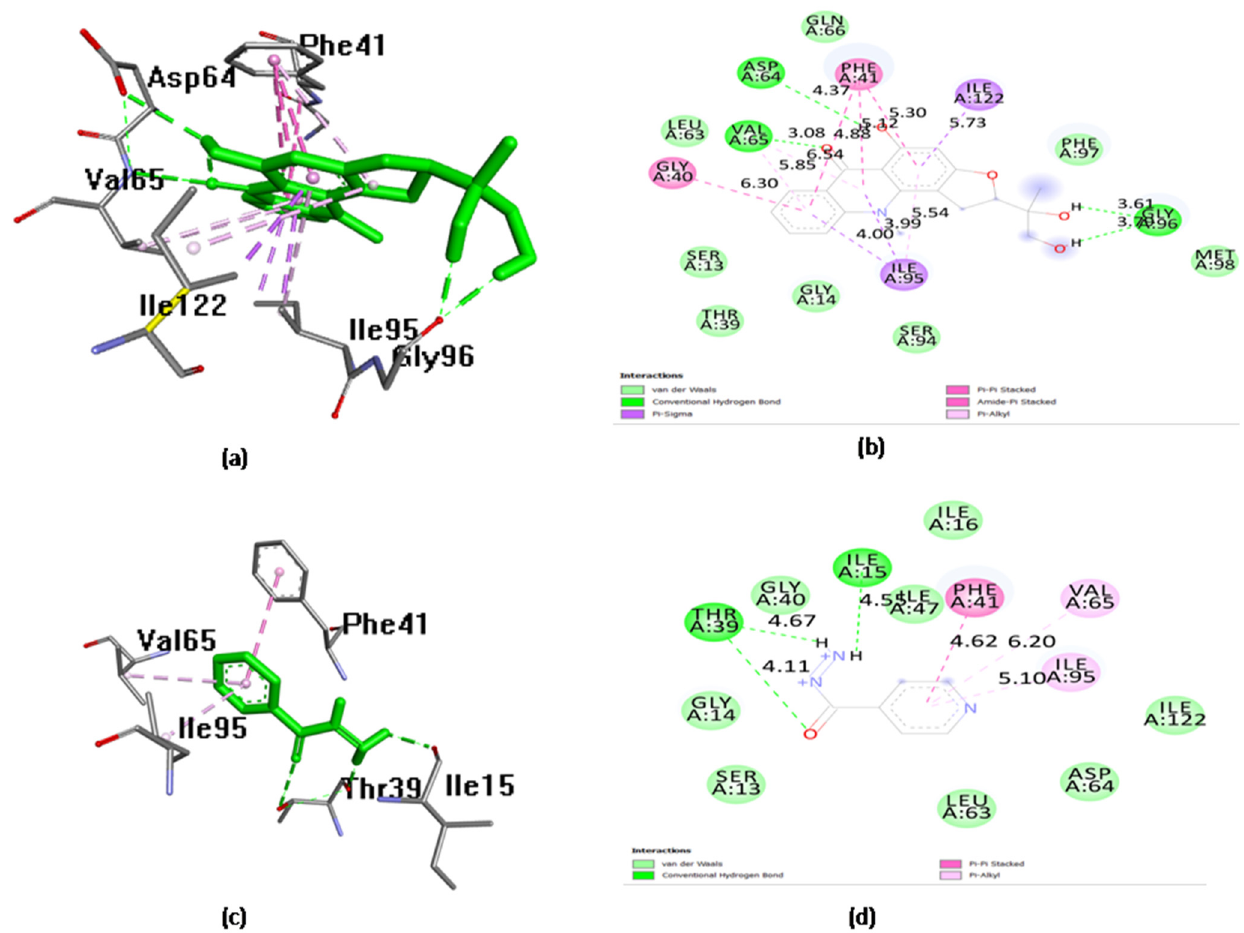
Figure 1. ( a ) Docked pose of gravacridonediol in the InhA binding site, showing the molecular interactions—hydrogen and hydrophobic bonds noted using green and pink/purple dashed lines, respectively; ( b ) 2D plot of the interactions between gravacridonediol and key residues of InhA, generated by BIOVIA Discovery Studio visualizer; ( c ) docked pose of triclosan in the InhA binding site, showing molecular interactions—hydrogen and hydrophobic bonds noted using green and pink/purple dashed lines, respectively; ( d ) 2D plot of interactions between triclosan and key residues of InhA, generated by BIOVIA Discovery Studio visualizer.